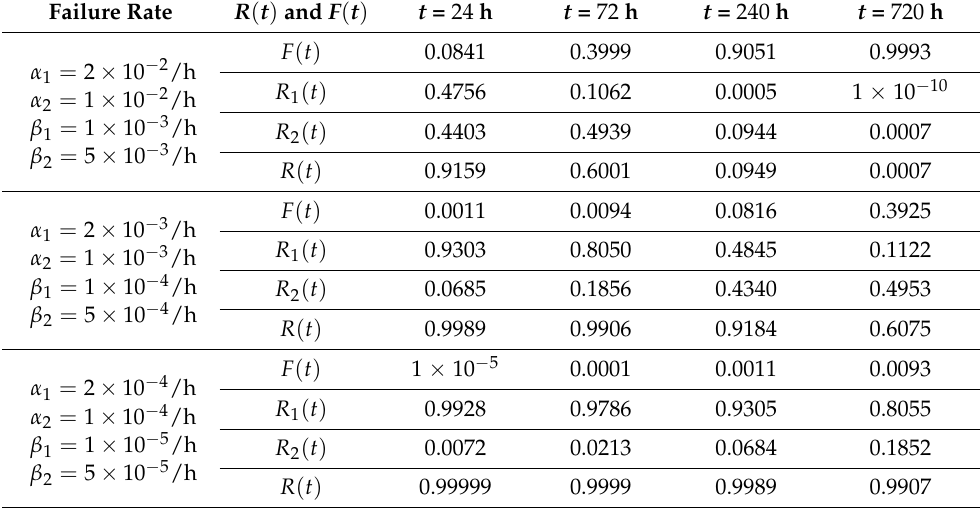
Table 2. Probability of the system in different